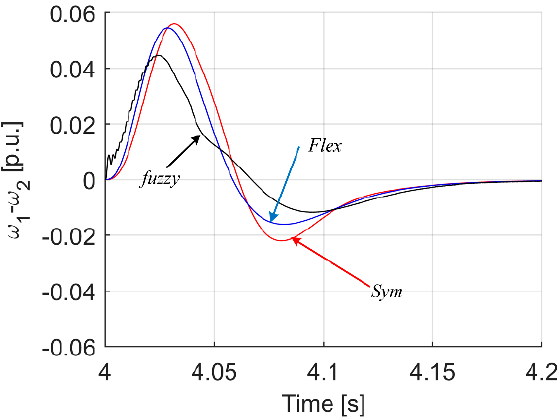
Figure 24. Transients of difference between motor and reference speed for case of reference speed change.